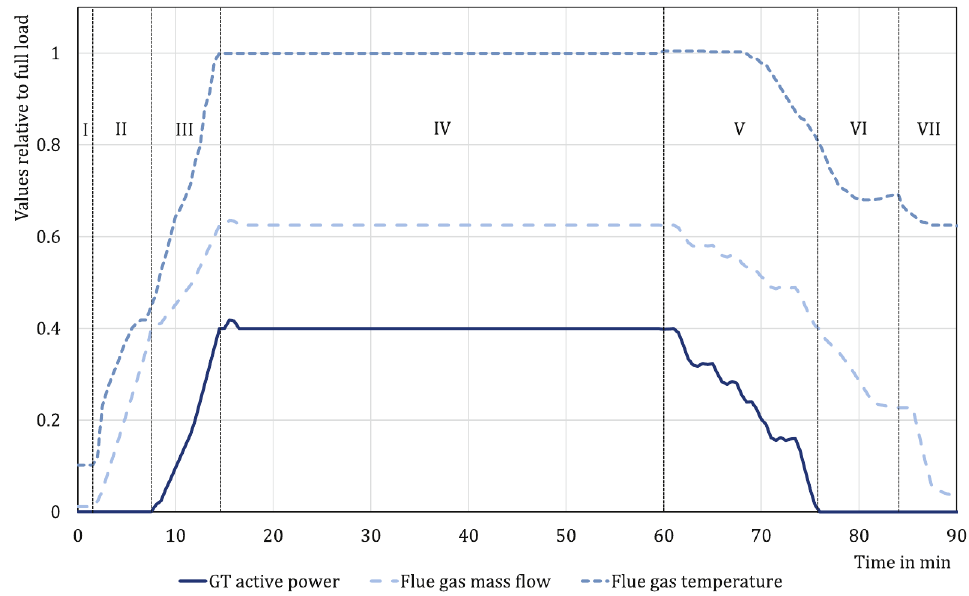
Figure 1. Applied load with respect to the operating time graph (I–III Start up; IV steady state; V–VII shut down) [11].